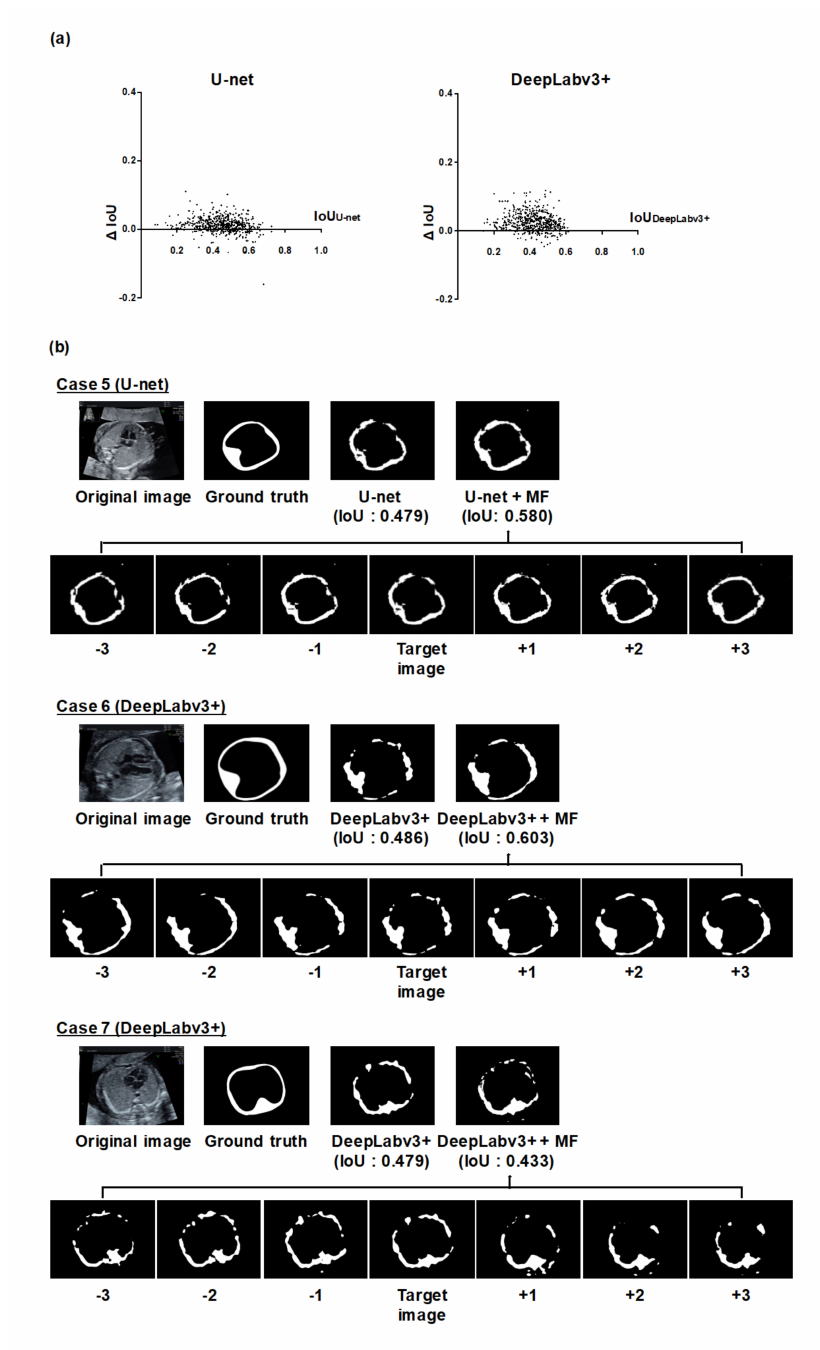
Figure 3. Analysis of the thoracic wall segmentation in the IoU metric using MF. ( a ) The di ff erences of the IoU values in all individual images using U-net or DeepLabv3 + and MF. We calculated the IoU of U-net or DeepLabv3 + (IoUU-net or IoUDeepLabv3 + ), the IoU of MF (IoUMF), and the di ff erence for the IoU values between them ( ∆ IoU = IoUMF − IoUU-net or IoUDeepLabv3 + ). CNN models were based on U-net and DeepLabv3 + . The x-axis represents the IoUU-net or IoUDeepLabv3 + , and the y-axis represents ∆ IoU. ( b ) Representative examples of the thoracic wall segmentation using MF. CNN models were based on U-net (case 5) and DeepLabv3 + (case 6, 7). The upper row of each case presents the prediction labels obtained from U-net or DeepLabv3 + alone and MF. The lower row shows the prediction labels of the neighboring frames integrated by MF. In case 5 and 6, the segmentation performance was improved by MF. On the other hand, in case 7, the segmentation performance worsened by